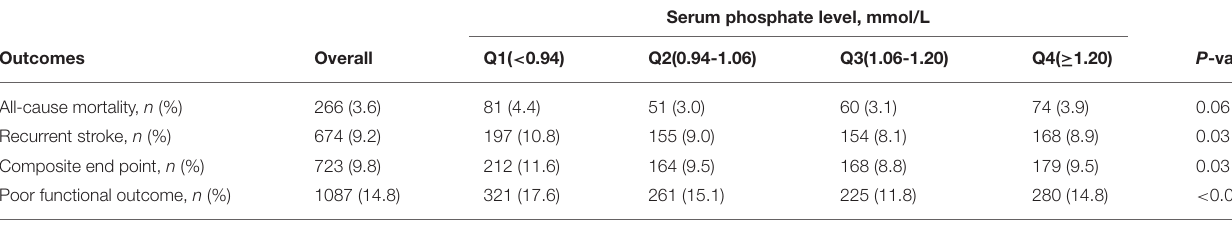
TABLE 2 | Rates of 1-year outcomes according to quartiles of serum phosphate level.